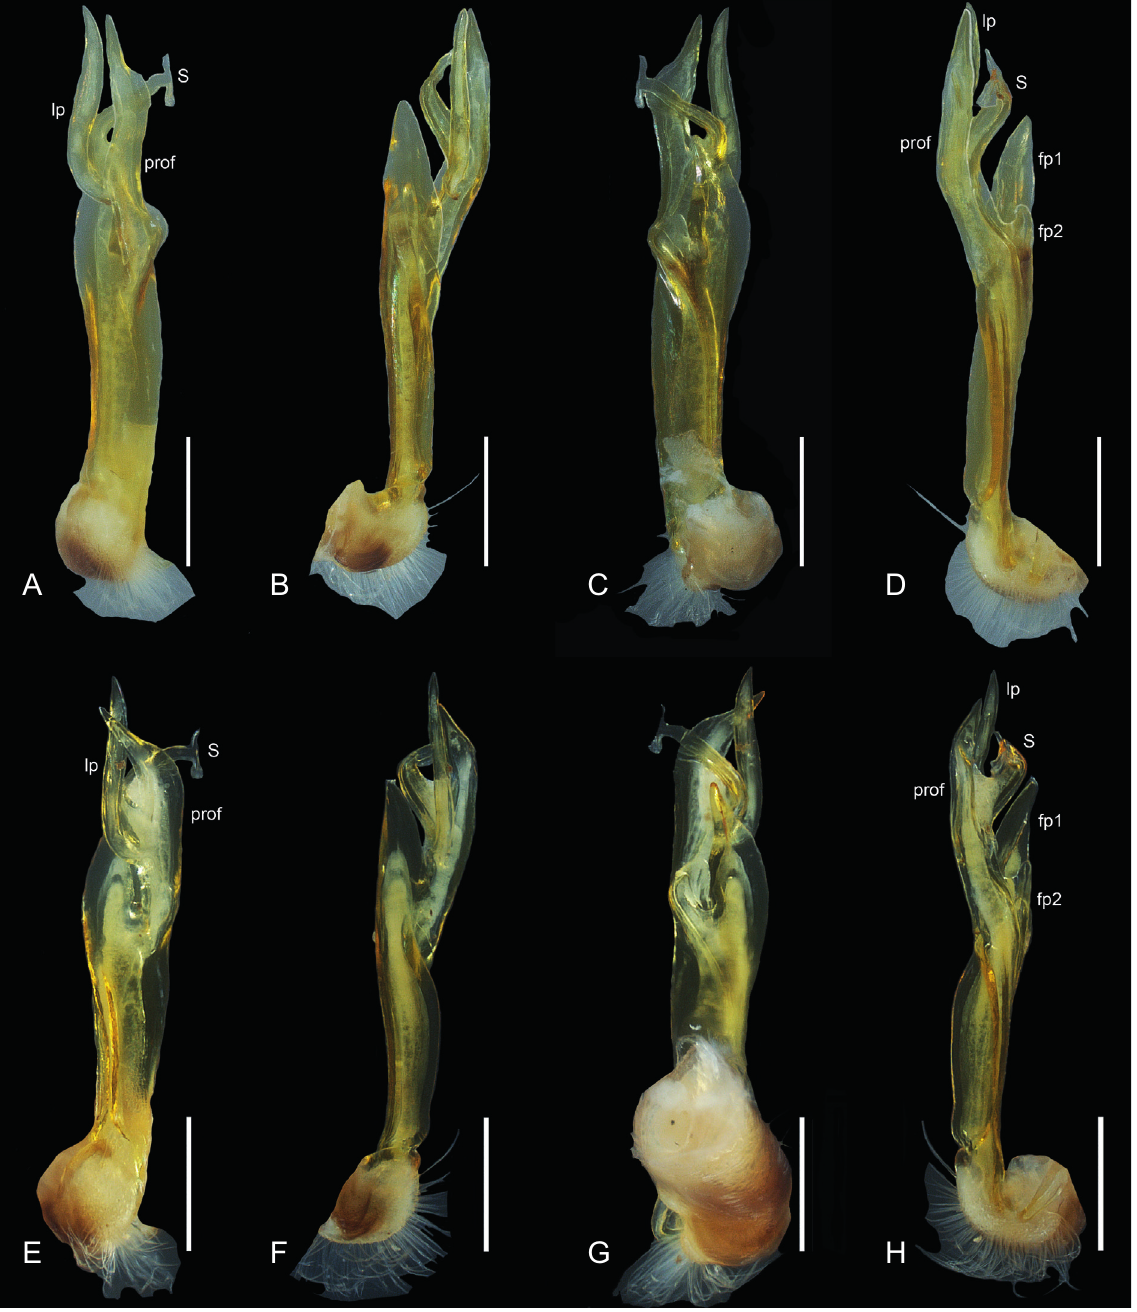
Fig. 19. Pogonosternum jeekeli Decker, sp. nov., ♂, right gonopod. A–D . NMV K-10252 from Dyer Creek. E–H . NMV K-10250 from Bemm River. A , E . Posterior view. B , F . Lateral view. C , G . Anterior view. D , H . Mesal view. Scale bars: 0.5